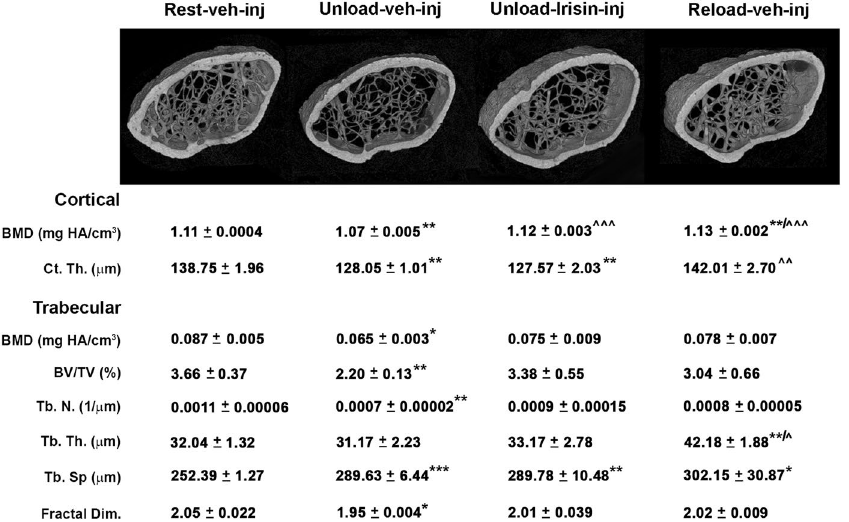
Figure 6. Treatment with r-Irisin recovers bone loss in femurs from hindlimb-suspended mice. Representative microCT-generated section images and calculated cortical and trabecular parameters of femurs obtained from normal loading mice (Rest vehicle-inj), unloaded mice treated with vehicle or recombinant Irisin (first r-Irisin injection after 4 weeks of hindlimb suspension, at the dose of 100 µ g kg − 1 per week for 28 days) and reloaded mice (Reload veh-inj). Cortical bone parameters included bone mineral density (BMD) and cortical thickness (Ct.Th). Trabecular bone parameters included bone mineral density (BMD), bone volume/total volume (BV/TV), trabecular number (Tb.N), trabecular thickness (Tb.Th), trabecular separation (Tb Sp) and Fractal Dimension. Data are presented as mean ± SEM. n = 6–7 mice per group. All data were normally distributed according to the Shapiro-Wilk normality test and analyzed by one-way ANOVA and Bonferroni’s post hoc analysis. Cohen’s d values were measured for non-significant differences of results and can be found as Supplementary Table S1. * p ≤ 0.05, ** p ≤ 0.01, *** p ≤ 0.001 versus Rest vehicle-injected mice. ^ p ≤ 0.05, ^^ p ≤ 0.01, ^^^ p ≤ 0.001 versus Unload vehicle-injected